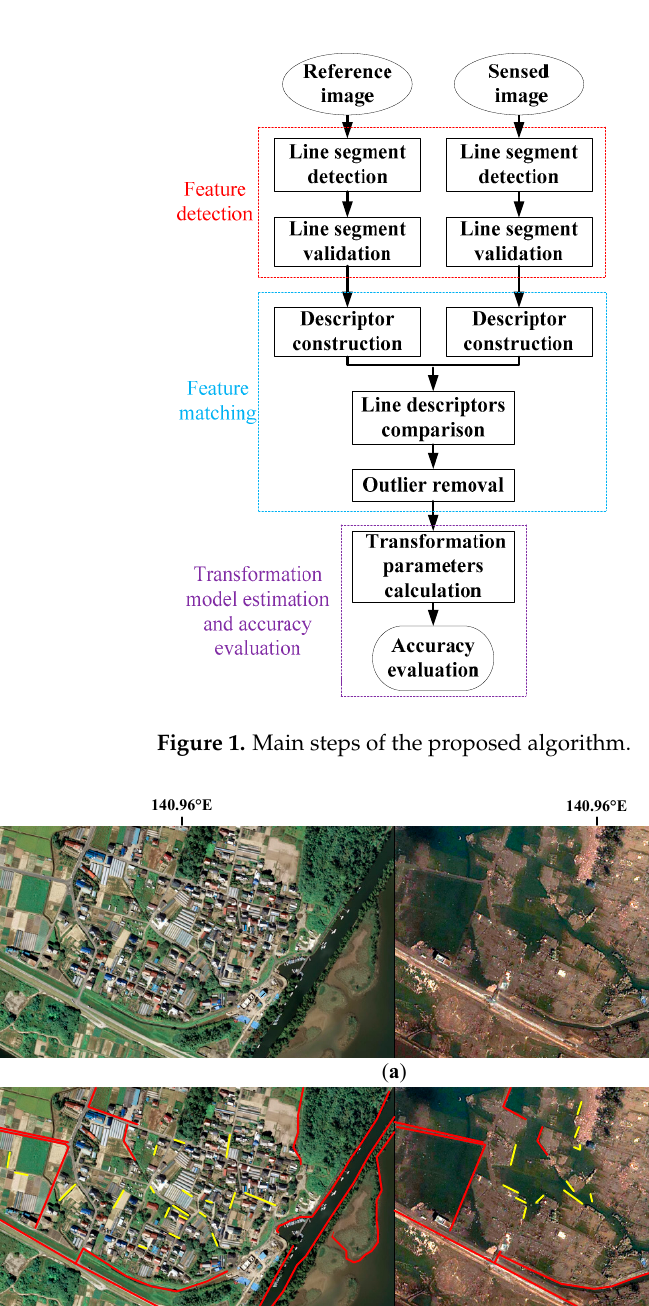
Figure 2. An image pair taken pre and post a tsunami. ( a ) The original images; ( b ) images with different types of line segments depicted in them.